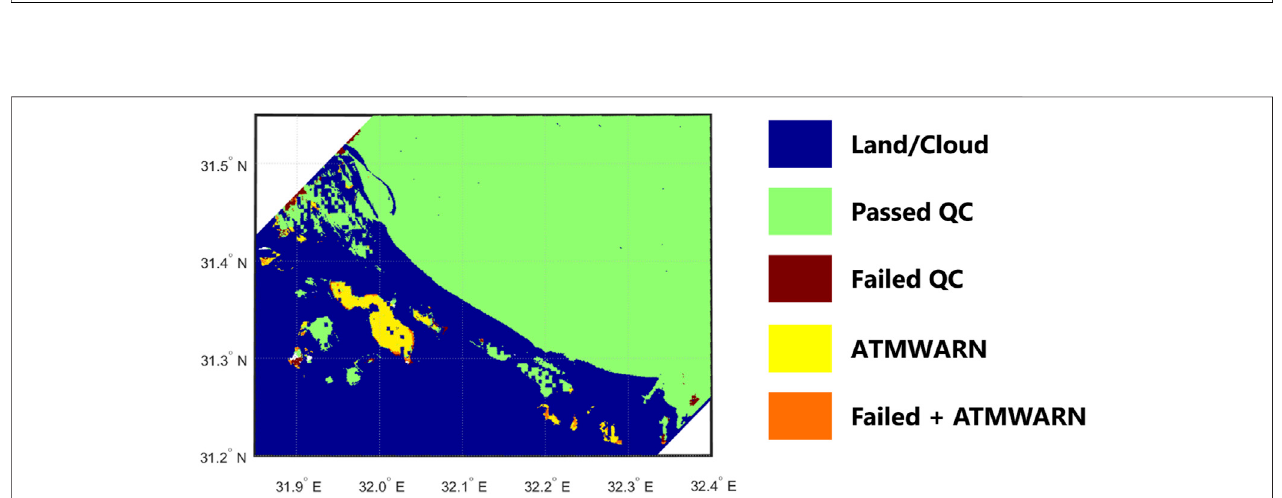
FIGURE 9 |(A) Mapped HICO scene on which the QWIP procedure was tested. (B) The AVW is compared to NDI, and (C,E) spectra deviating from the QWIP are nominally deemed to fail quality control criteria, and those (D) within the uncertainty bounds of the polynomial pass. The spectral color scheme relates to the corresponding AVW values, as de fi ned in (A) .